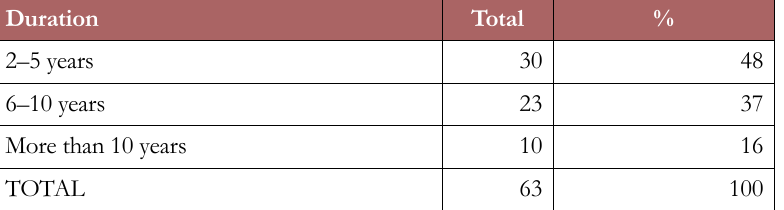
Table 3. Working Experience of Respondents